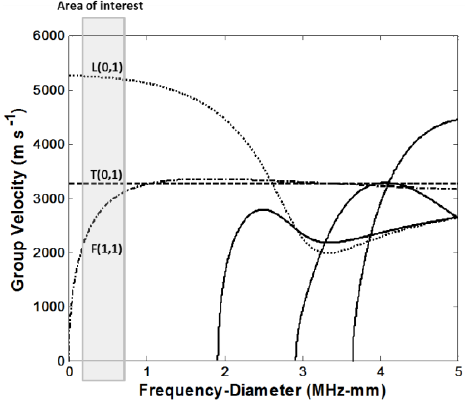
Figure 2. Dispersion curves for cylindrical carbon steel rods: Group velocity versus frequency-diameter product.